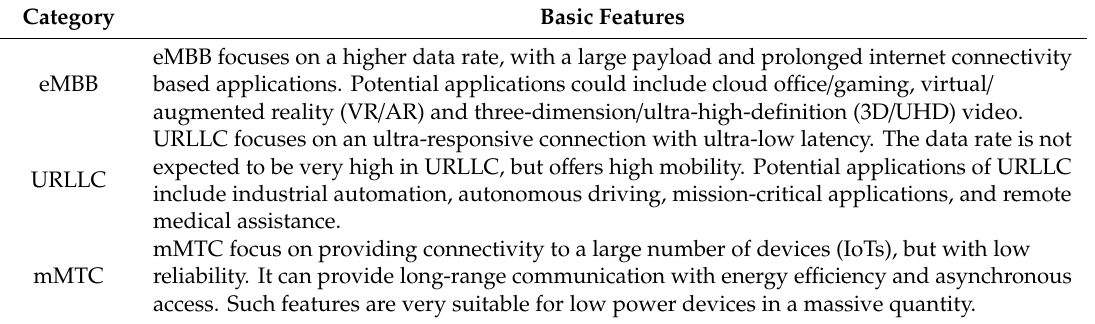
Table 1. Intended features for the categories defined by the International Telecommunication Union